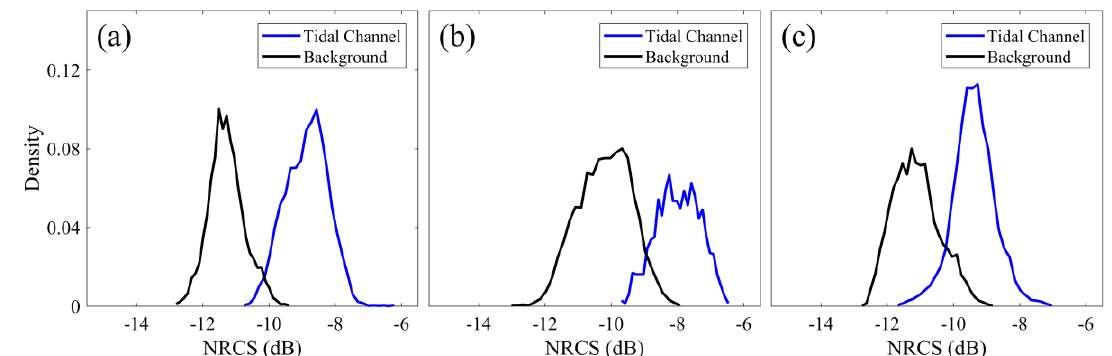
Figure 5. Density histograms of NRCS values from the region over the tidal channel and the background, acquired ( a ) on 20 April 2005 with C-band VV-polarization, ( b ) on 27 August 2007 with C-band, HH-polarization, and ( c ) on 19 March 2007 with L-band, HH-polarization, respectively. A low-pass filter was applied to smooth the speckle noise.